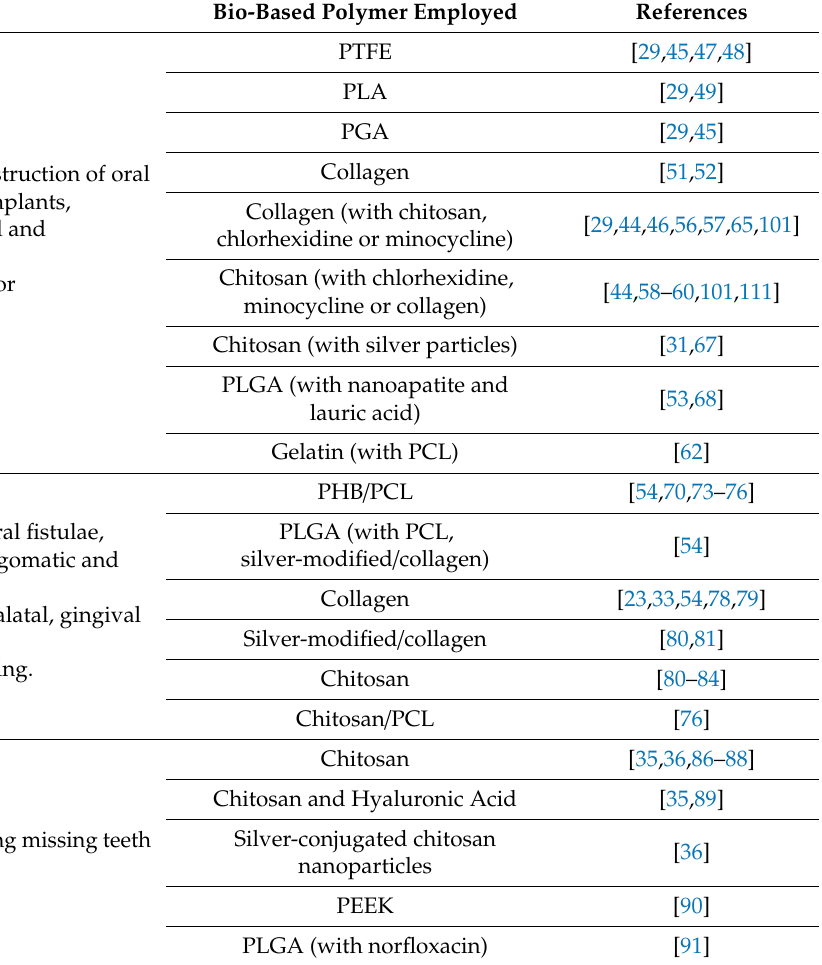
Table A1. Review’s Overview: most clinically applied systems for cranio-maxillary regeneration, clinical applications, composition and